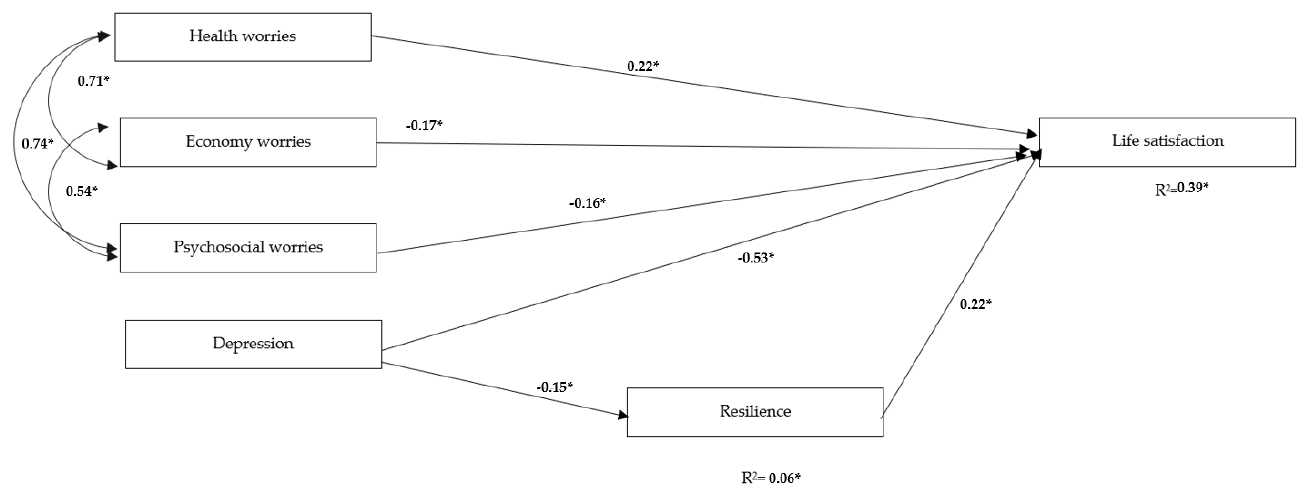
Figure 2. Final model of causal relationships between dimensions of worries, dimensions of DASS, and resilience on life satisfaction. * Statistically significant relationship. * = p ≤ 0.05; χ 2 = 2377.43, df = 620, p ≤ 0.001; S-B χ 2 = 2133.49, df = 620, p ≤ 0.001; S-B χ 2 / df = 3,44; RMSEA = 0.05 (IC = 0.050–0.054); SRMR = 0.08; CFI = 0.87; IFI = 0.88. Note. An SEM was performed, and the items were introduced to form the scales, but due to space constraints, they are not shown in the figure.